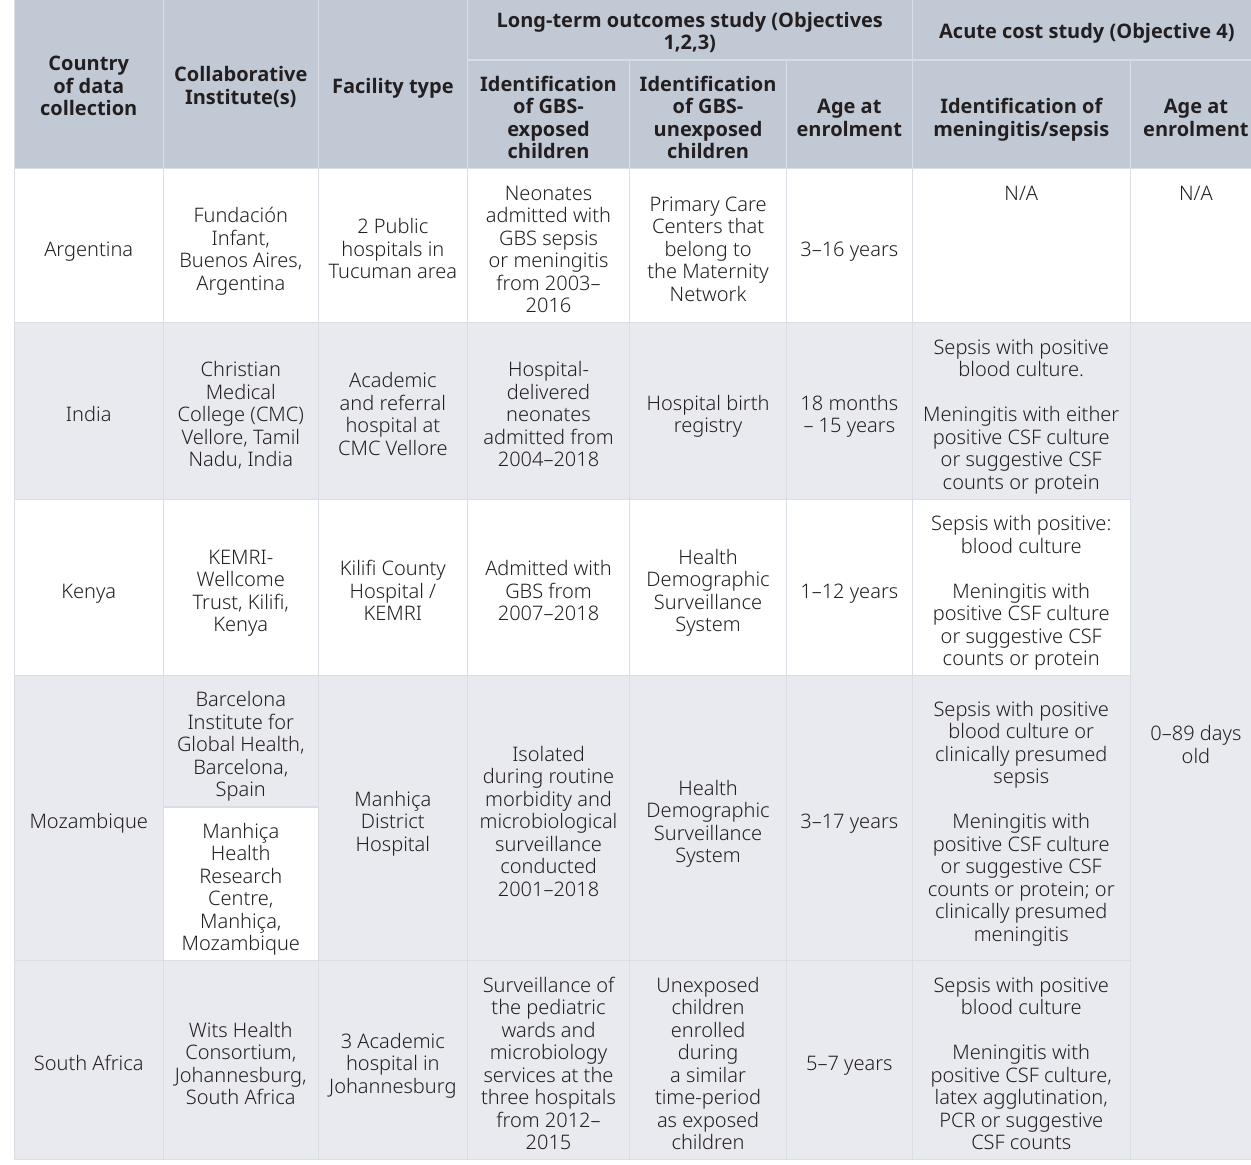
Table 1. Description of collaborative research partners and study population participating in long-term and acute cost studies.